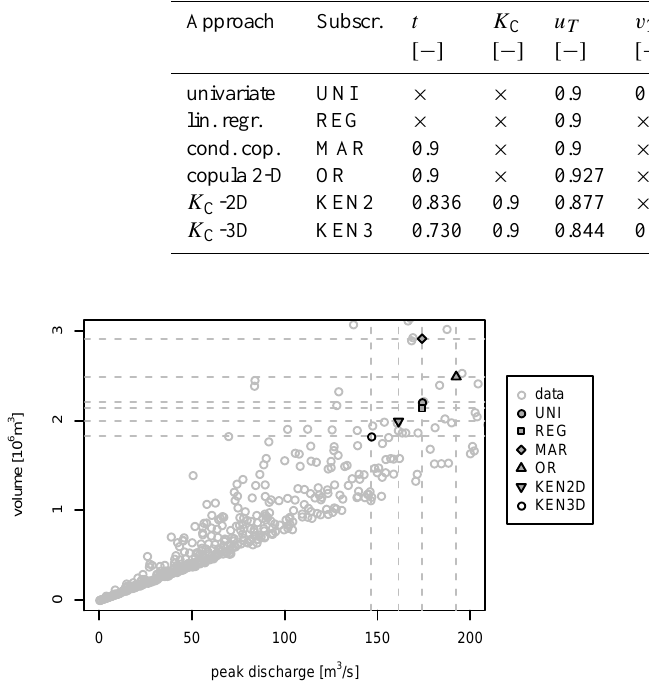
Fig. 6. An overview of the different design values for a design return period of 10yr obtained with the different definitions. Note that only a subset is shown and the data points exceed both